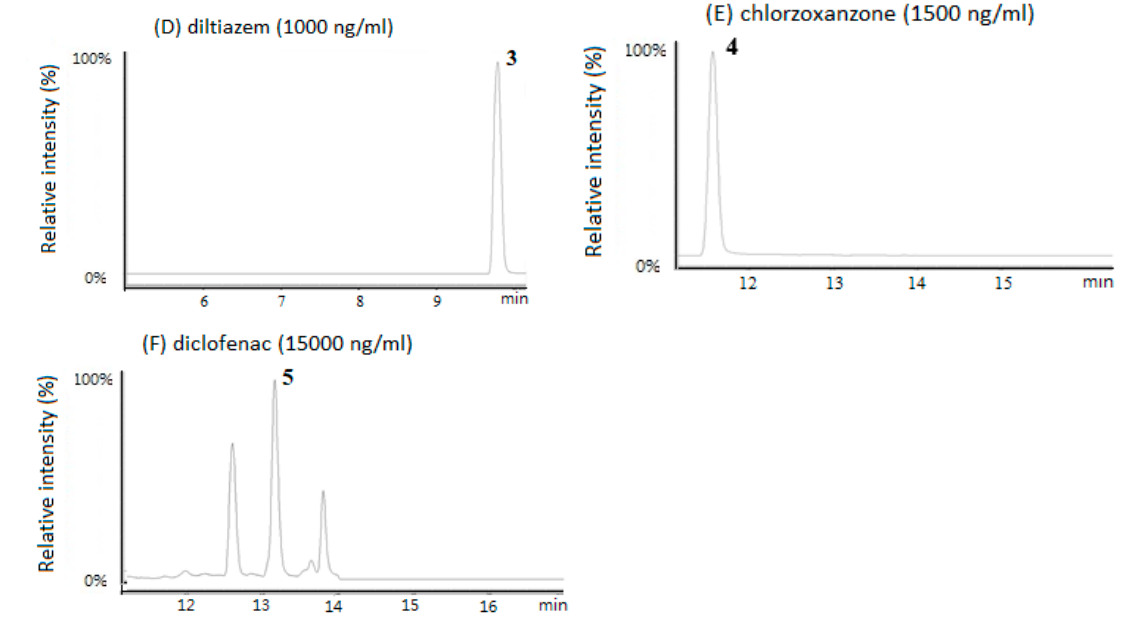
Figure 1. HPLC/MS (single quadrupole) selective ion monitoring chromatogram of five drugs in rat plasma ( a ), theophylline ( b ), dextromethorphan ( c ), diltiazem ( d ), chlorzoxazone ( e ), and diclofenac ( f ). Peaks: 1, theophylline; 2, dextromethorphan; 3, diltiazem; 4, chlorzoxazone; 5, diclofenac. Data acquisition was via selected ion monitoring (SIM). Details are described in Materials and Method.